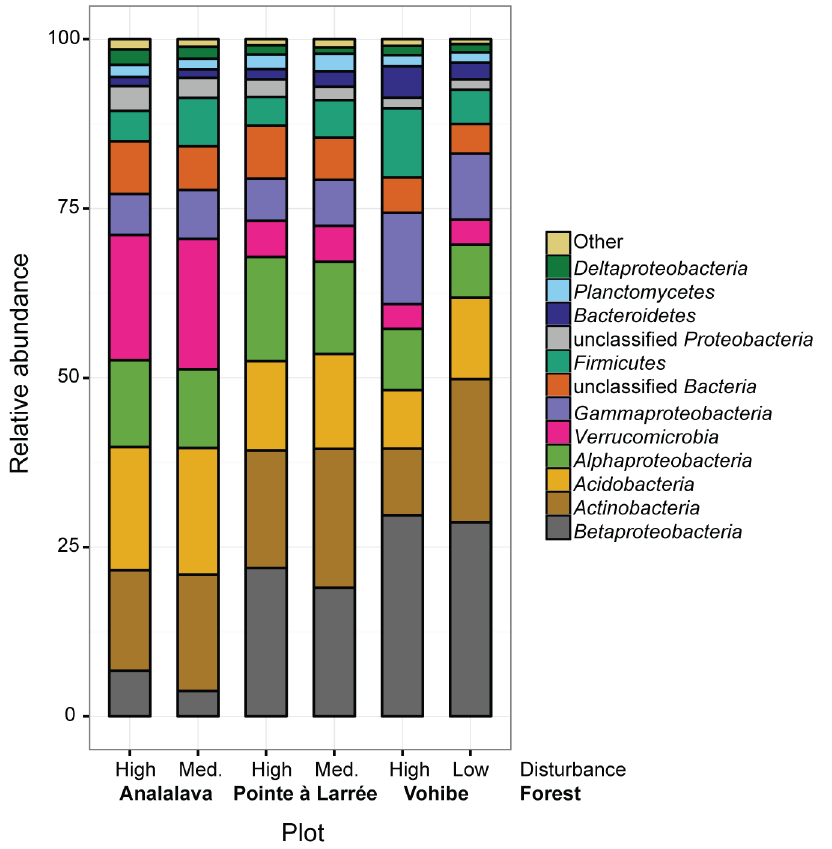
Figure 1. Average relative abundance of dominant bacterial taxa by plot. Sequences in 3% OTUs were classified and grouped at the phylum level, with Proteobacteria further divided by class. Taxa representing , 1% of the total sequences were grouped as Other.